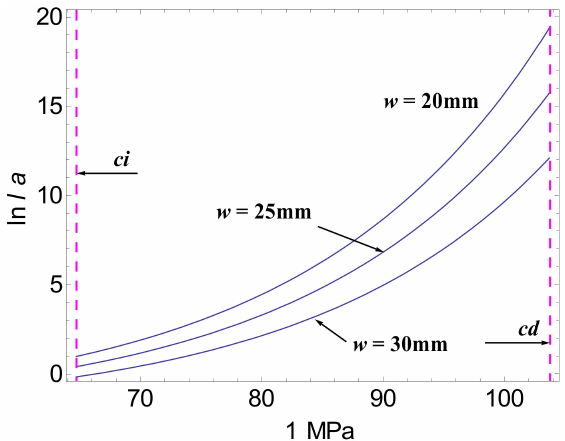
Figure 9. Variation curves of the wing crack length during stable crack propagation of rock under